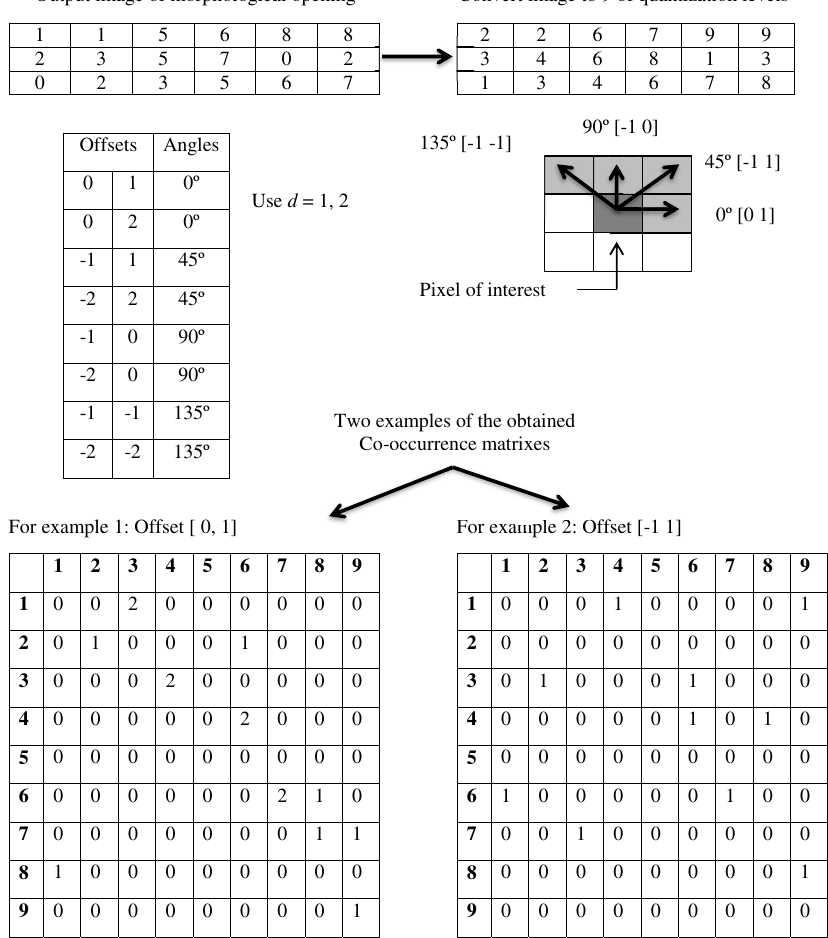
FFor exampmm le 2: OF